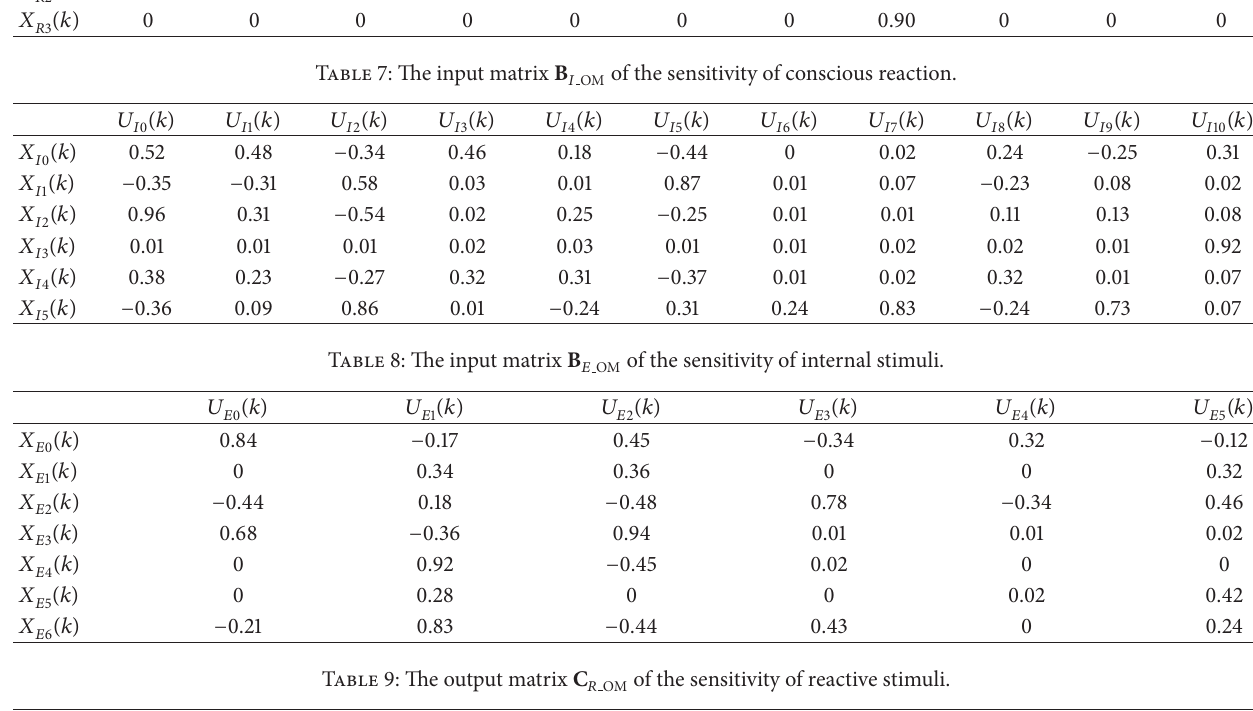
Table 9: The output matrix C 𝑅